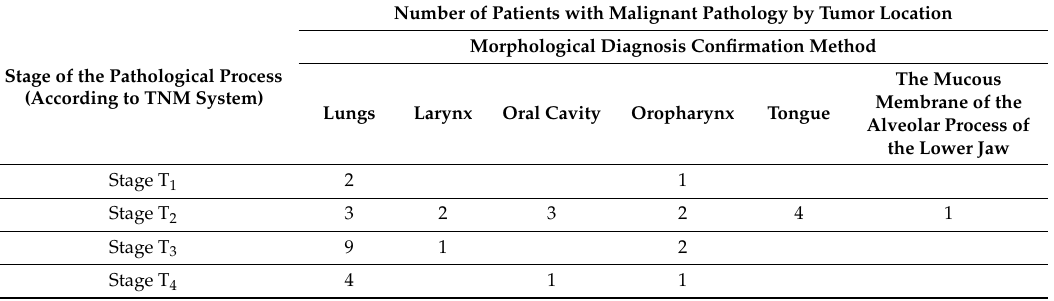
Table 1. Characteristics of the study set of